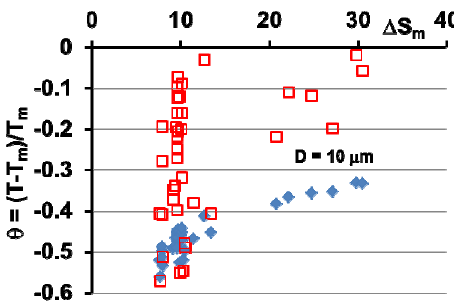
Figure 5. Condensation temperatures of 13-atom superclusters and crystallization temperatures in 10 micrometer droplets versus the melting entropy in J/K/mole. The squares are the reduced formation temperatures of 13-atom superclusters, which are ready to grow. These temperatures are larger than or equal to the reduced temperatures of spontaneous crystallization around them represented by diamond points.